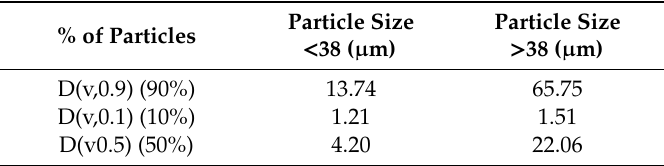
Table 3. Particle size analysis of the glass.